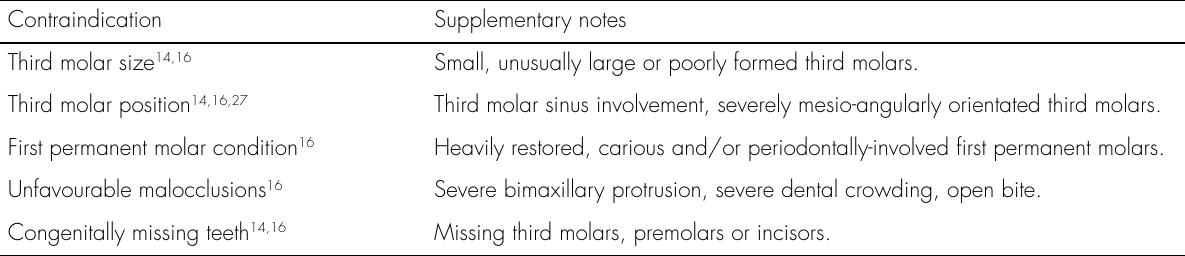
Table III. Contraindications for permanent maxillary second molar